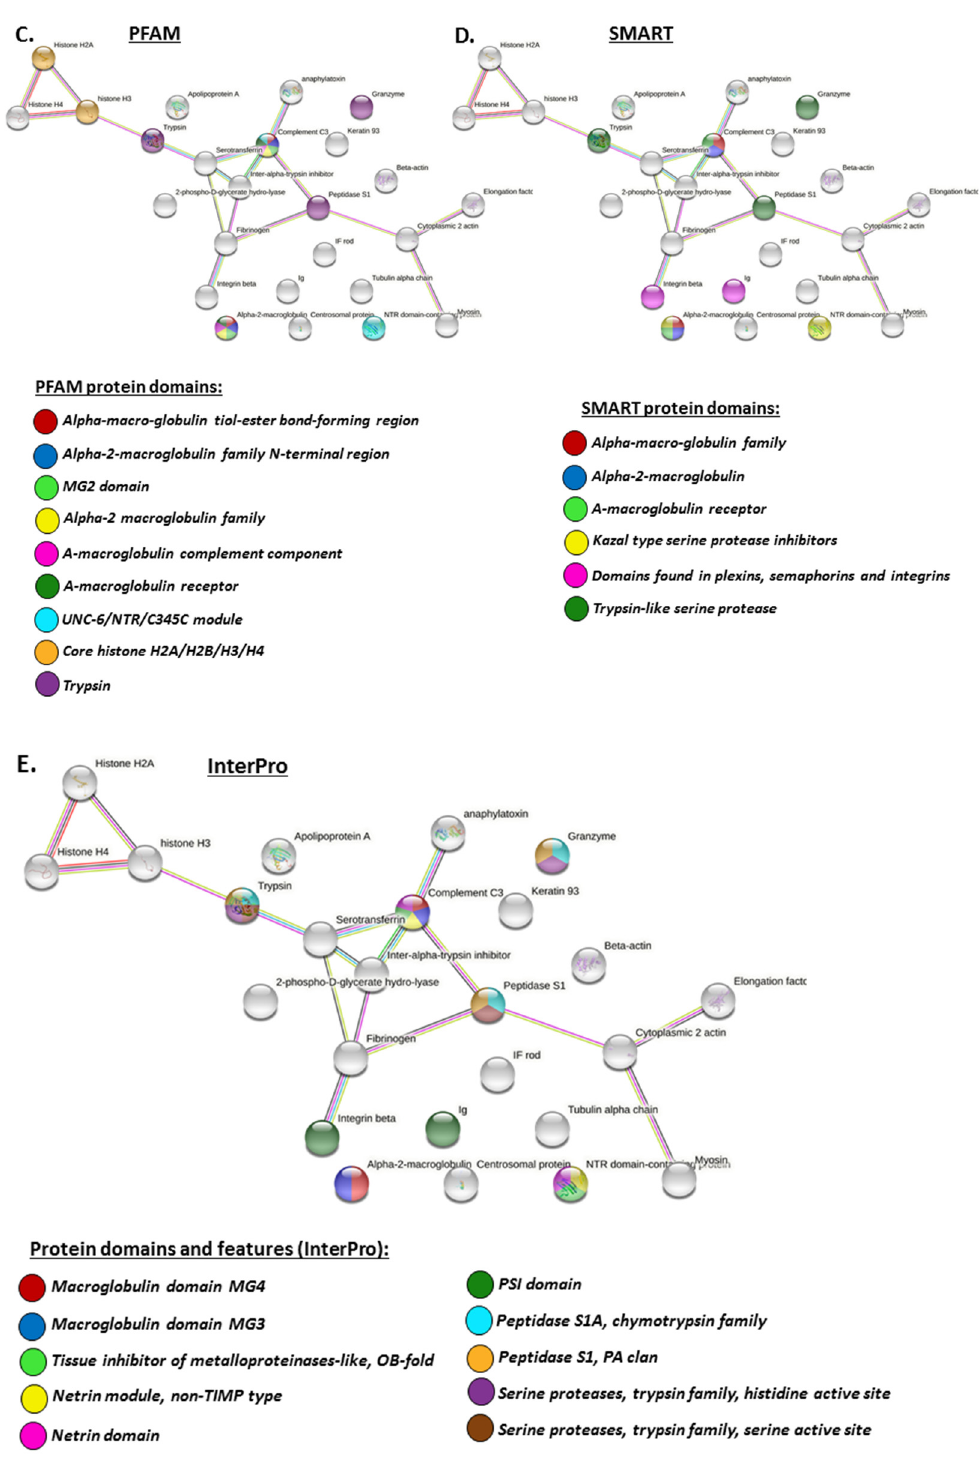
Figure 4. ( A ) Protein interaction networks for deiminated proteins in halibut EVs. Local network clusters and UniProt keywords are indicated by the colour coded nodes. See colour key for nodes and interaction networks in the figure. ( B ) Reactome protein interaction networks for deiminated proteins in halibut EVs. Reactome pathways are indicated by the coloured nodes, as shown in the figure. ( C , D ) PFAM and SMART protein interaction networks for deiminated proteins in halibut EVs. PFAM and SMART protein domains are indicated by the coloured nodes, see colour code in the figure. ( E ) InterPro protein interaction networks for deiminated proteins in halibut EVs. InterPro protein domains and features are indicated by the coloured nodes; see colour code in the figure.